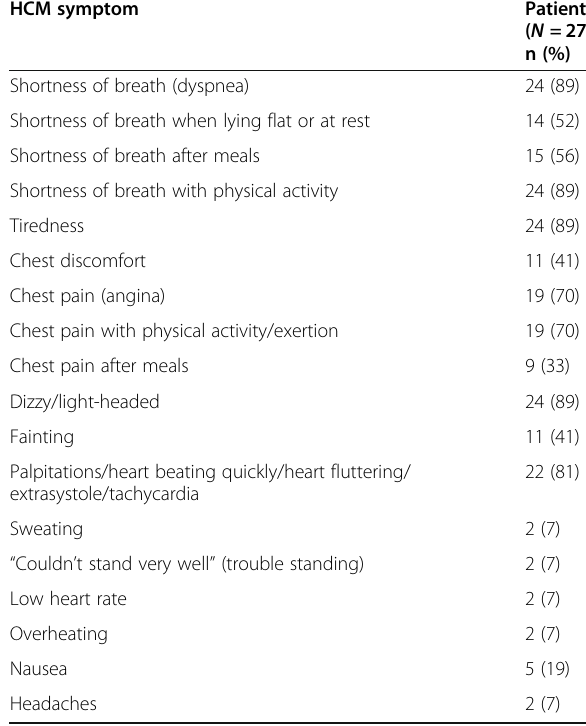
Table 3 Frequency of HCM symptoms reported by at least